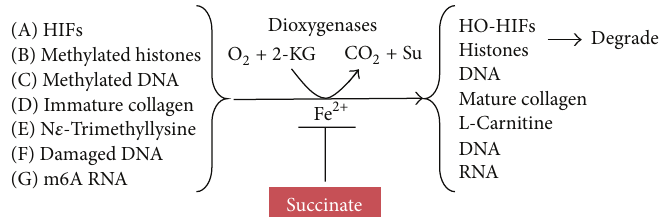
Figure 4: Potential 𝛼 -KG-dependent dioxygenase targets susceptible to succinate inhibition. In SDH-deficient cells, succinate accumulates in mitochondria and diffuses into the cytosol and nucleus. Succinate inhibits 𝛼 -KG-dependent dioxygenases resulting in accumulation of (A) HIF1 𝛼 and HIF2 𝛼 , (B) hypermethylation of histones, (C) hypermethylation of deoxycytidine, (D) accumulation of immature collagen, (E) accumulation of N 𝜀 -trimethyllysine, (F) damaged DNA, and (G) accumulation of N6-methyladenosine on